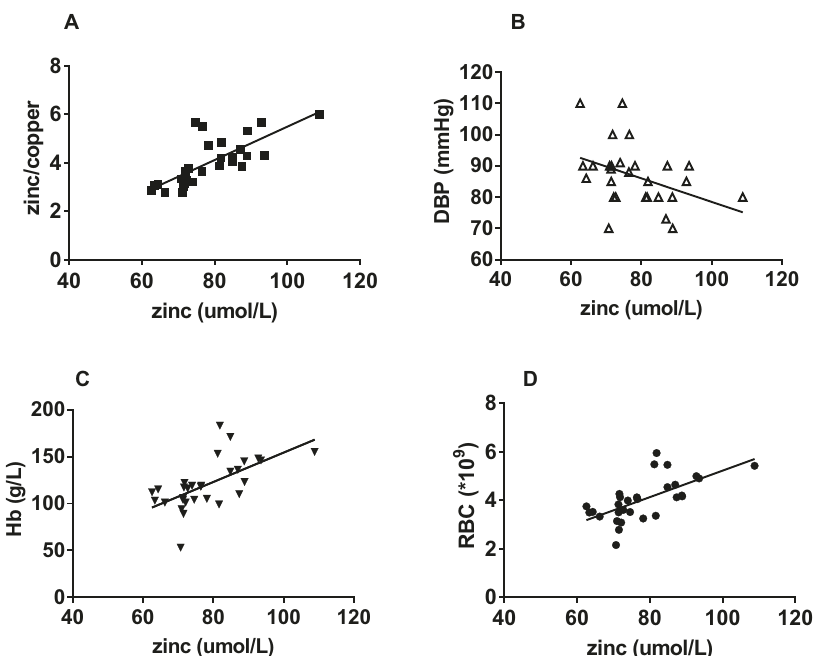
Fig. 5 Correlation between zinc levels and clinical indicators of patients with DN. According to the Pearson correlation analysis, zinc was A positively correlated with zinc/copper ( r = 0.75, P < 0.01); B negatively correlated with DBP ( r = − 0.409, P < 0.05); C positively correlated with Hb ( r = 0.617, P < 0.01); and D positively correlated with RBC ( r = 0.652, P < 0.01).